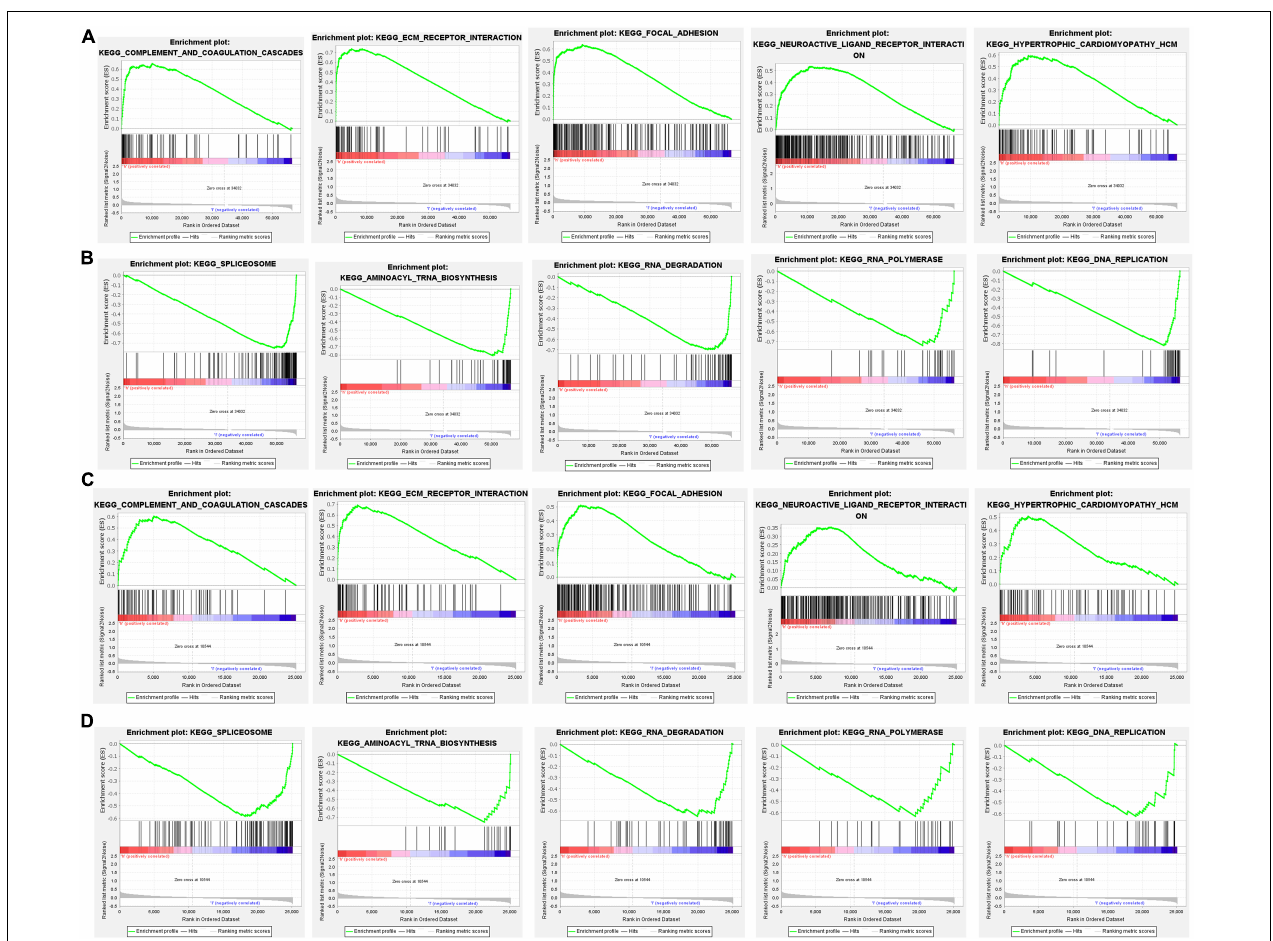
FIGURE 9 | The gene set enrichment analysis (GSEA) analysis between different risk groups. (A,B) KEGG enrichment in the TCGA cohort, (C,D) Kyoto Encyclopedia of Genes and Genomes (KEGG) enrichment in the GEO cohort.